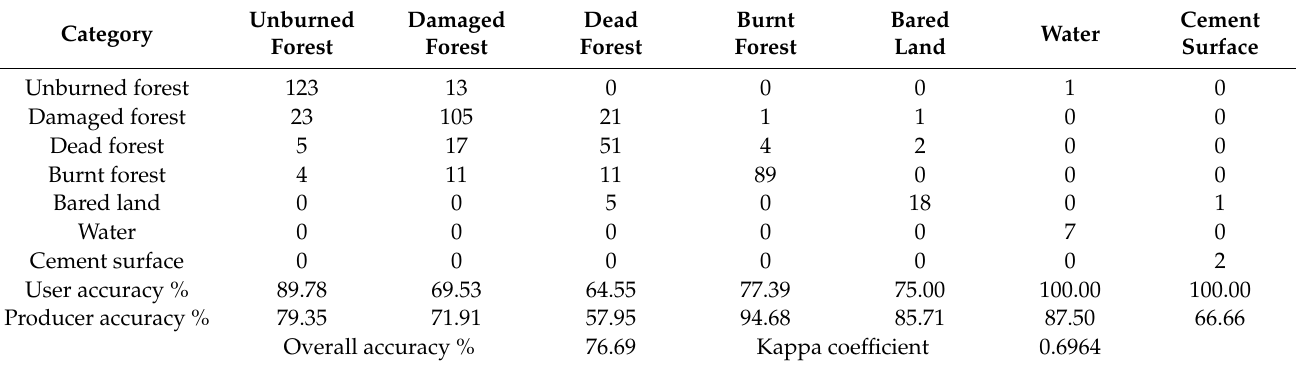
Table 5. Accuracy evaluation of the support vector machine